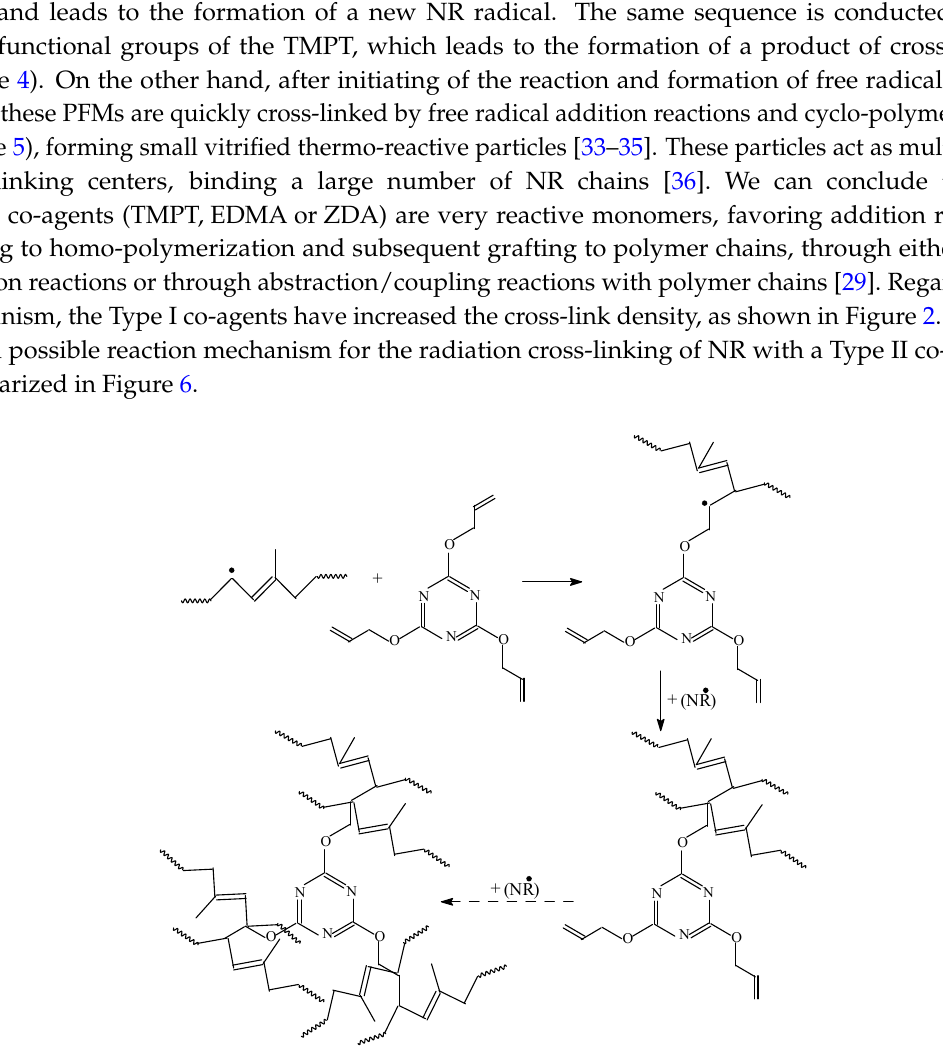
Figure 6. Possible mechanism of NR cross-linking and grafting in the presence of TAC by EB irradiation.